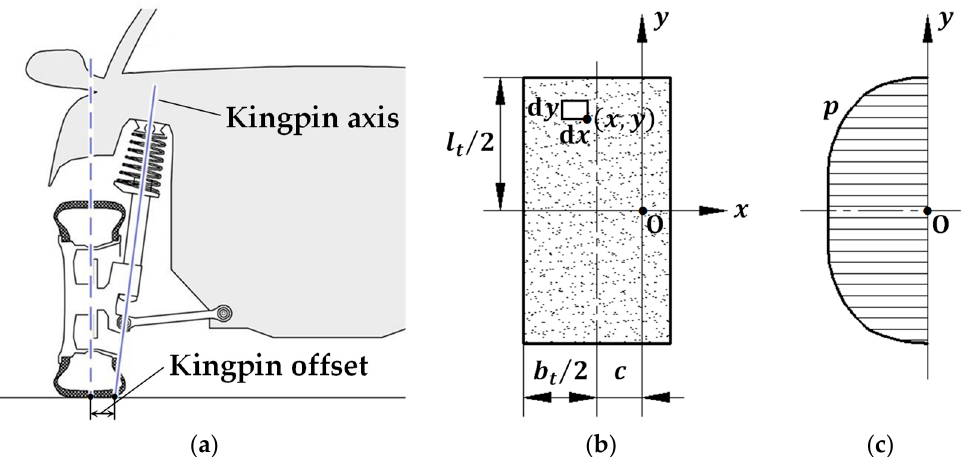
Figure 5. Steering model of the steered wheel: ( a ) Schematic diagram of the kingpin axis and kingpin offset; ( b ) geometric model of the low-speed steering friction torque; and ( c ) longitudinal pressure distribution of the tire.